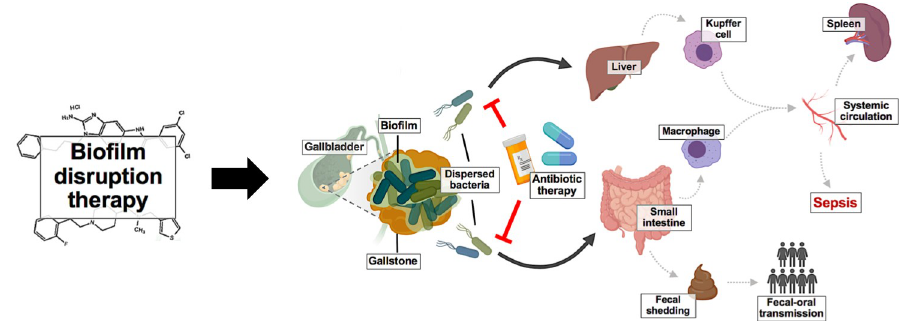
Fig 6. Model of a dual therapy approach for the safe and efficient disruption of Salmonella biofilms in vivo . Following treatment with anti-biofilm agents, Salmonella biofilms on the surface of gallstones are disrupted, and the released bacteria disseminate via the biliary tract to the small intestine and/or liver. Here, disseminated Salmonella can proliferate and cause tissue damage, or escape phagocytosis and gain access to the bloodstream resulting in systemic infection, sepsis, or even death. Dissemination of Salmonella to the small intestine can also lead to fecal contamination and increasing the risk of transmission. Concurrently administering traditional antibiotic therapy with anti-biofilm agents mitigates the aforementioned risks by killing bacteria as they are released from the biofilm, and thereby serves as a safe and efficient means of treating biofilm-mediated chronic carriage of Salmonella . Images created with